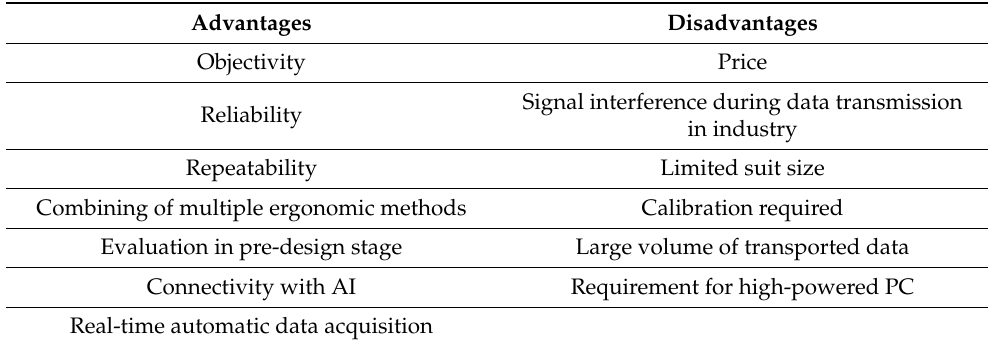
Table 3. Advantages and disadvantages of using motion capture for ergonomic assessment compared to standard methods. Source: own processing.